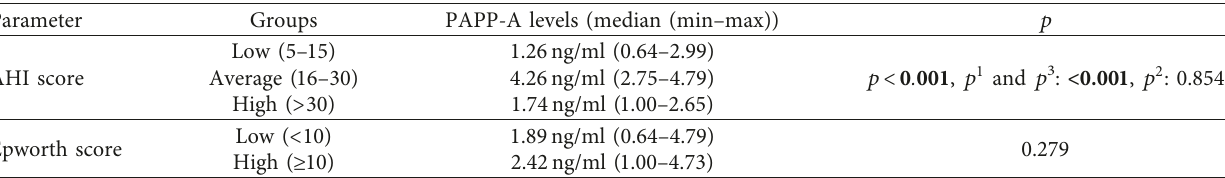
Table 6: PAPP-A levels in groups organized according to AHI score and Epworth